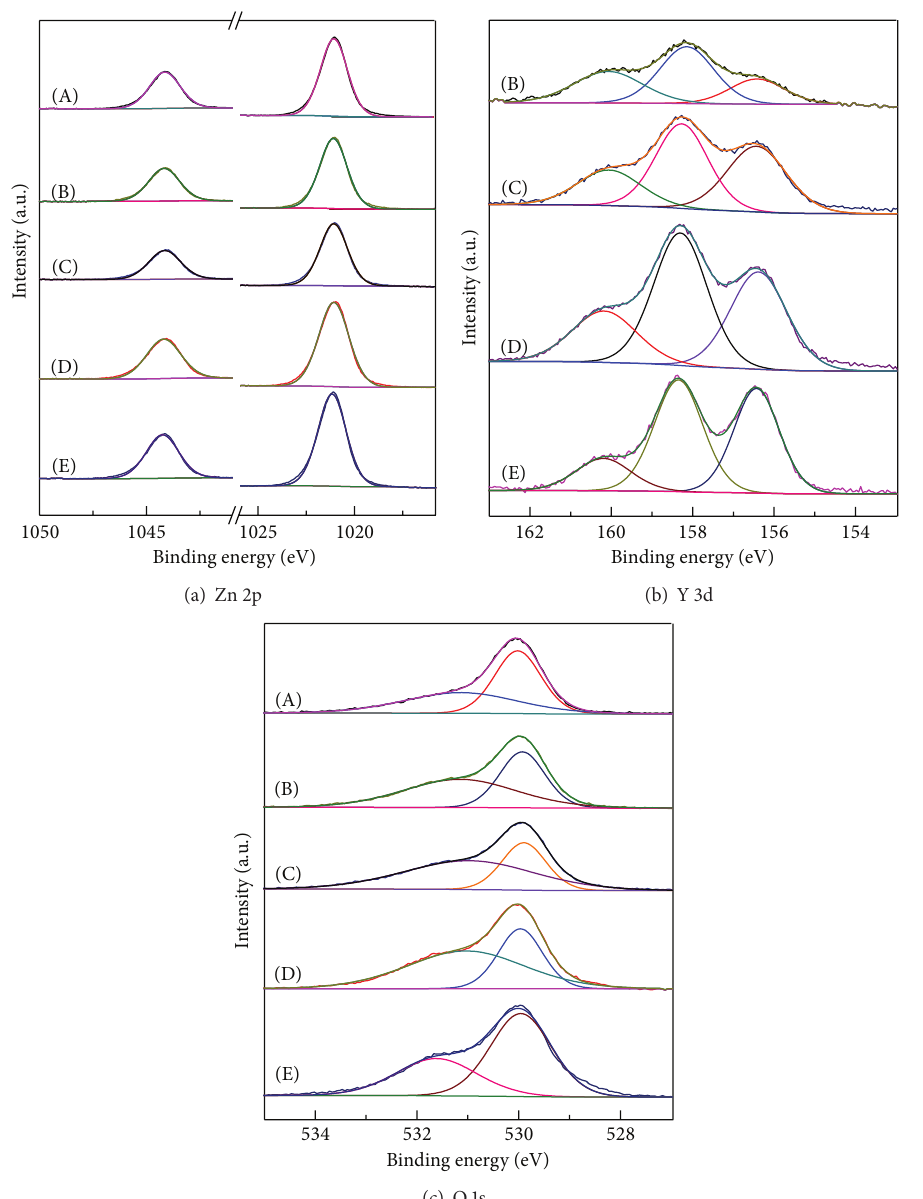
Figure 4: XPS spectra of (a) Zn 2p; (b) Y 3d; and (c) O 1s in ZnO (A), 0.25%-Y 2 O 3 -ZnO (B), 0.50%-Y 2 O 3 -ZnO (C), 0.75%-Y 2 O 3 -ZnO (D), and 1.00%-Y 2 O 3 -ZnO